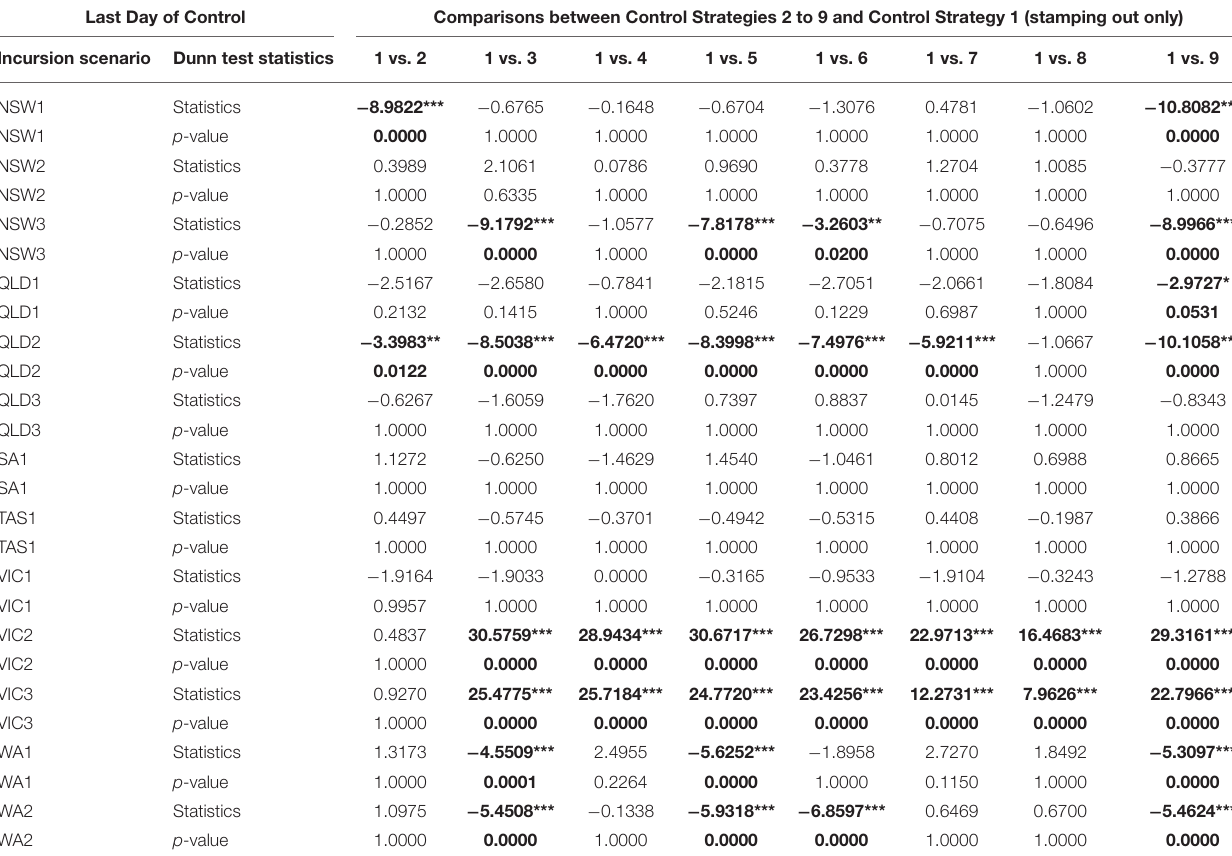
TABLE 7 | Dunn tests on last day of